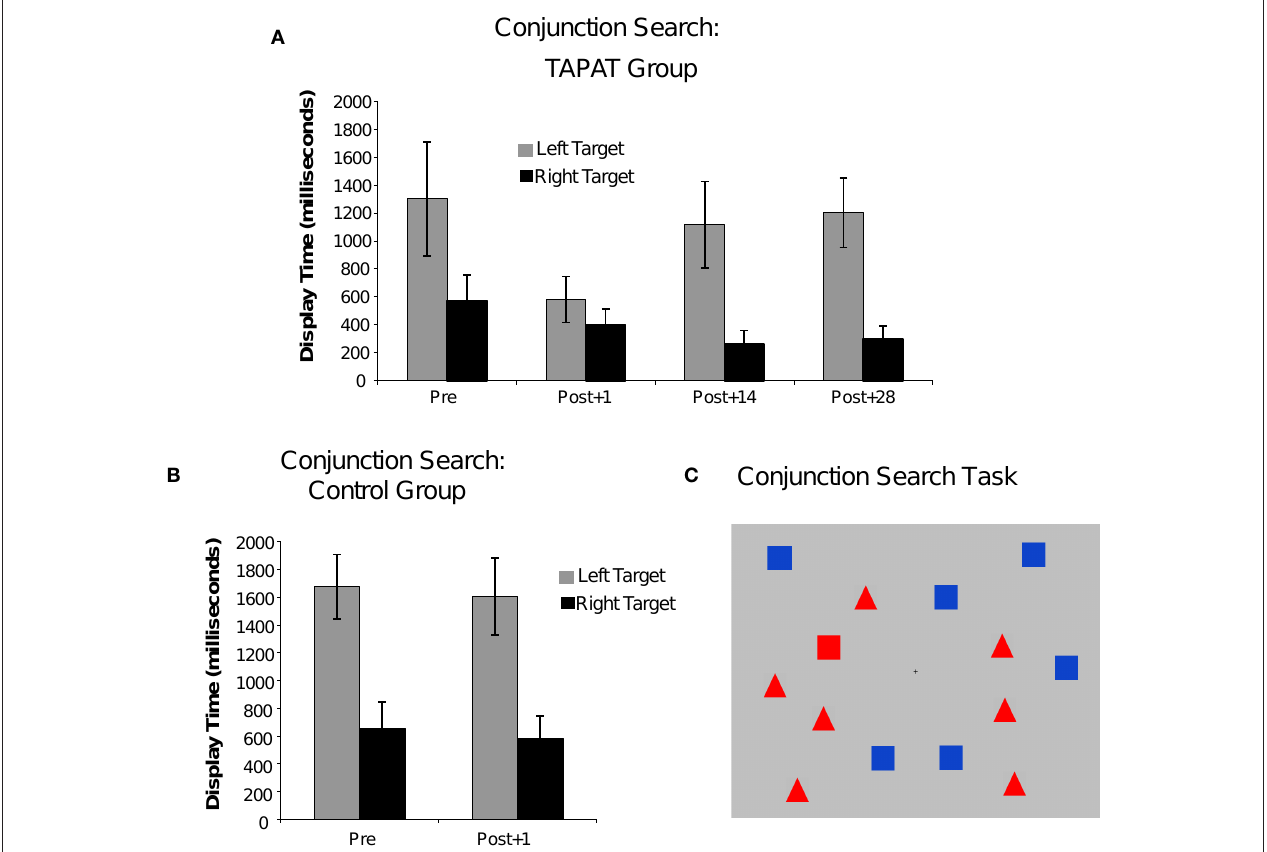
Figure 4 | original conjunction search results for TAPAT group (A) and control group (B). The display time is the amount of time that the target (red square) had to be shown for patients to correctly identify it 75% of the time. This was calculated separately for right and left targets (error bars represent the standard error of the mean). (C) is an example of a left target present